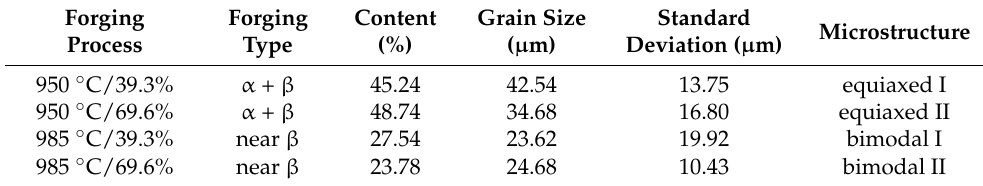
Figure 1. Microstructures of different forged TC4 titanium alloys. ( a ) Equiaxed I; ( b ) equiaxed II; ( c ) bimodal I; ( d ) bimodal II. Table 2. Measurement results of primary α phase content, grain size, and standard